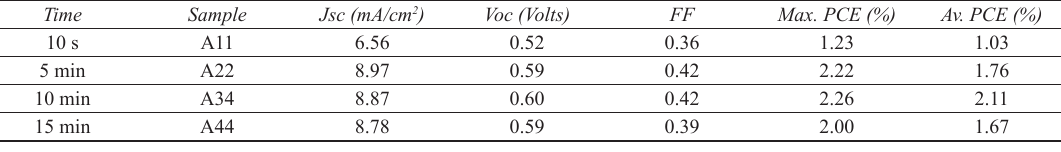
/P3HT:PC BM/MoO /Ag 2 61 3